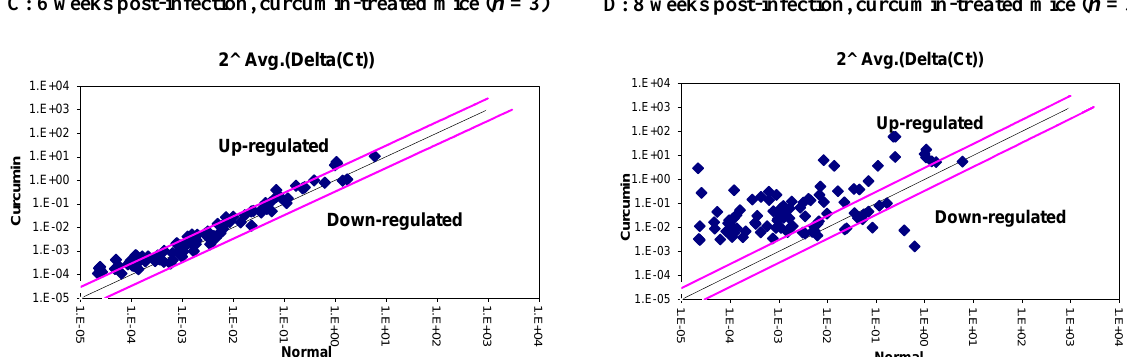
Figure 3. Relative expression level (2 −ΔCt ) for the 84 mouse inflammatory response and immunity encoding genes, between normal mice and Helicobacter pylori- infected mice at Week 6 post-infection ( A ) and at Week 18 post-infection ( B ); and between normal mice and Helicobacter pylori -infected mice treated with curcumin at Week 6 post-infection ( C ) and at Week 18 post-infection ( D ). Values denote the means obtained for each of the mice analyzed in each group, each mouse tested in duplicate (± SD). The grey lines indicate a three-fold change in gene expression